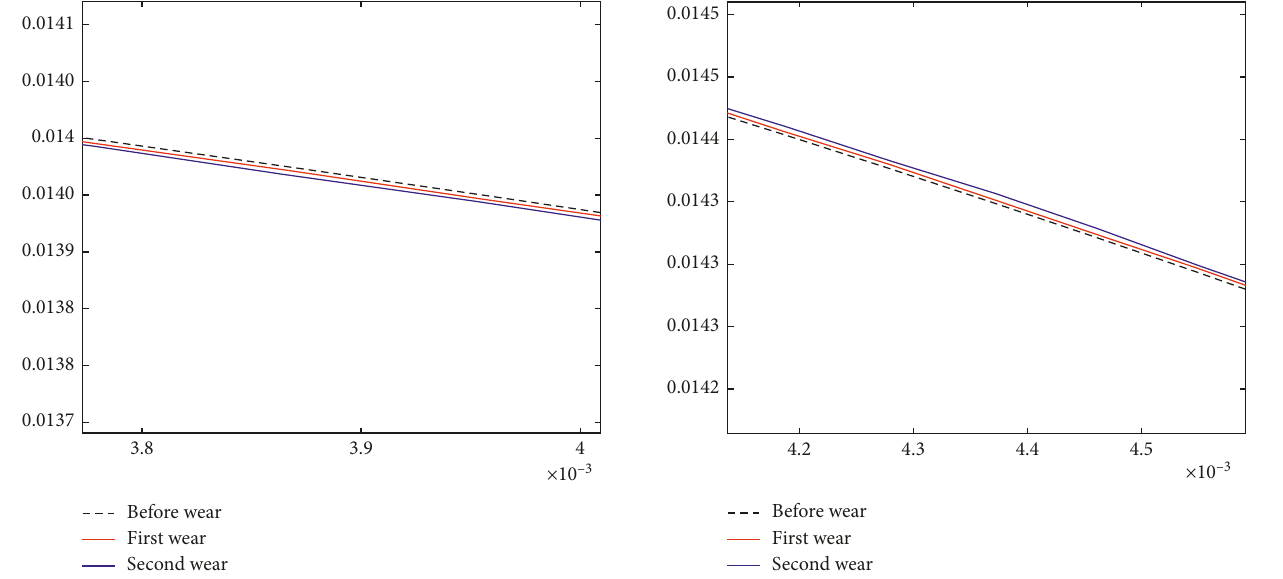
Figure 11: Local enlarged drawing of the shaft surface of joint A .